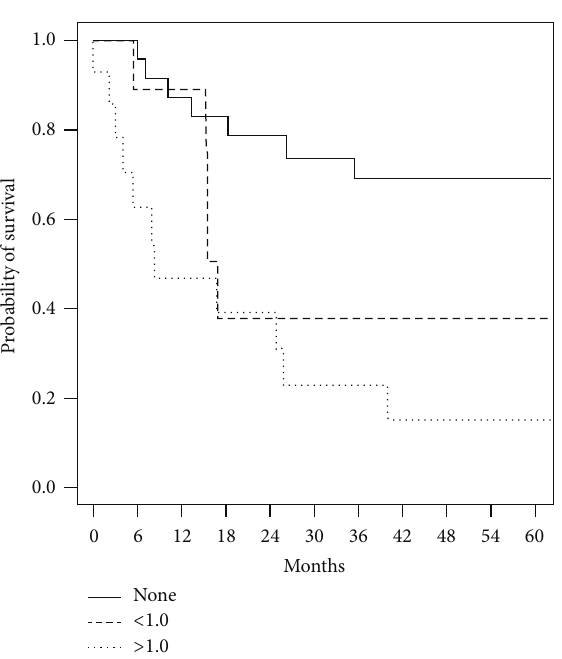
Figure 2: Age-adjusted survival by cytoreductive